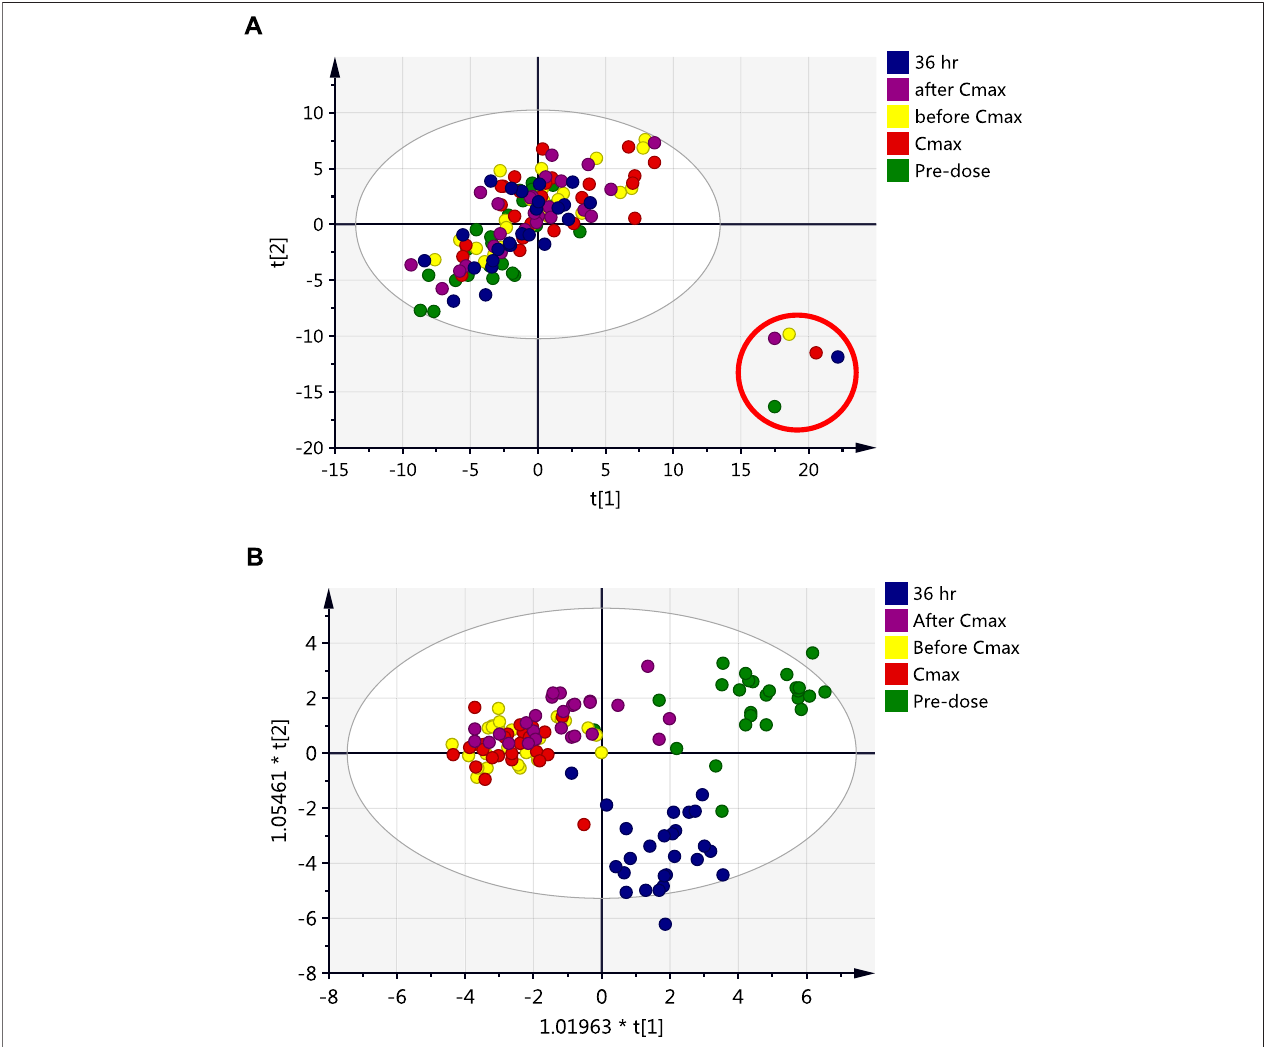
FIGURE 1 | Scores plots of the metabolite pro fi le of serum samples obtained from 26 healthy subjects after single dose of metformin at fi ve time points; pre-dose (baseline level, green), and 1.5 h before C max (yellow), C max (red), 2 h after C max (purple) and 36 h post-drug administration (blue). (A) PCA (R 2 X (cid:2) 0.71, Q 2 (cid:2) 0.44), (B) OPLS-DA (R2X (cid:2) 0.28, R2Y (cid:2) 0.40, Q2 (cid:2) 0.27).